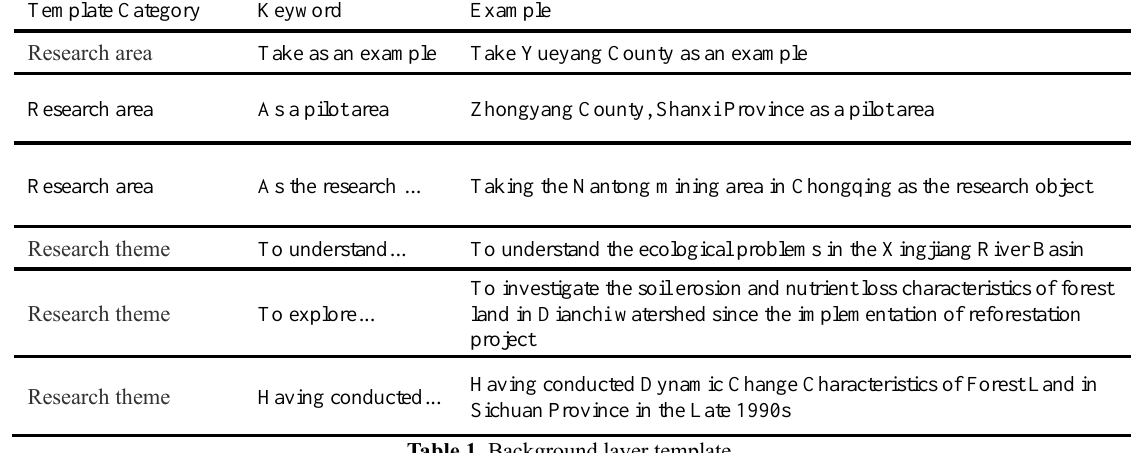
Table 1 . Background layer template.